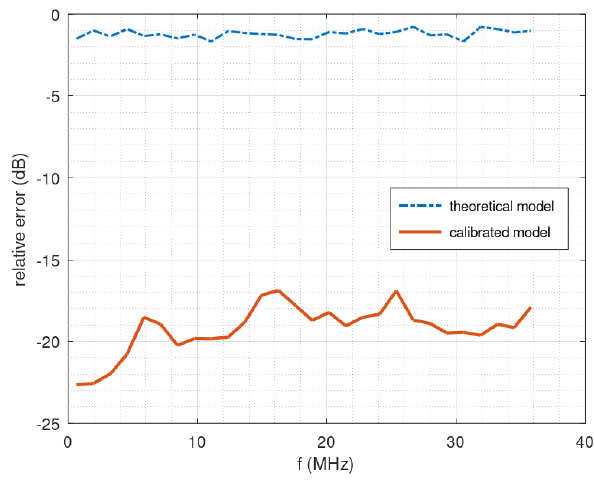
Figure 11. Relative error between observed and predicted system output, as a function of output frequency.